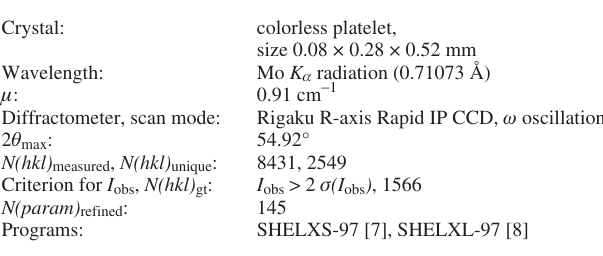
Table 1. Data collection and handling.